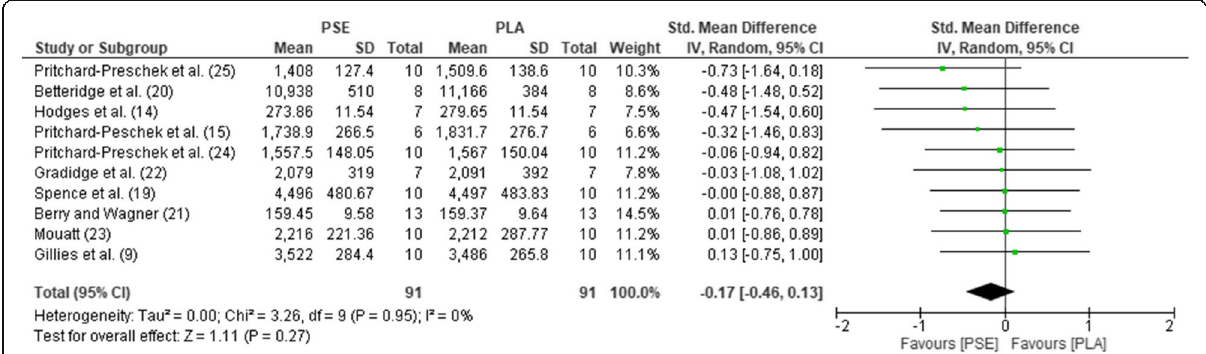
Fig. 3 Forest plot for effects of PSE on TT with 95% confidence intervals, PSE, pseudoephedrine; PLA, placebo; SD, standard deviation; Std., standardised; IV, instrumental variables; CI, confidence interval. Negative effect sizes represent a shorter TT performance due to PSE.